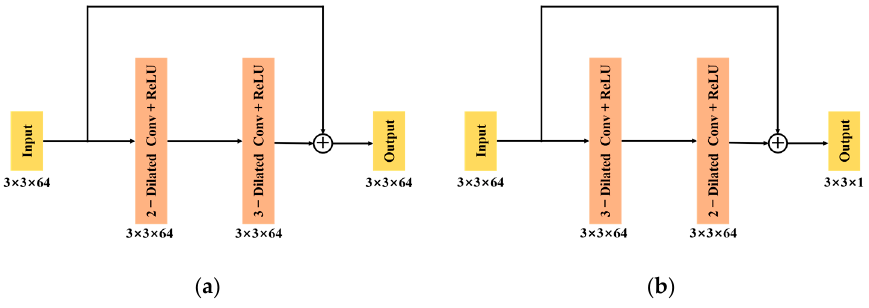
Figure 4. Diagram of skip connection structure in the proposed model. ( a ) Connecting dilated convolution layer 1 to dilated convolution layer 3. ( b ) Dilated convolution layer 4 to dilated convolution layer 7.